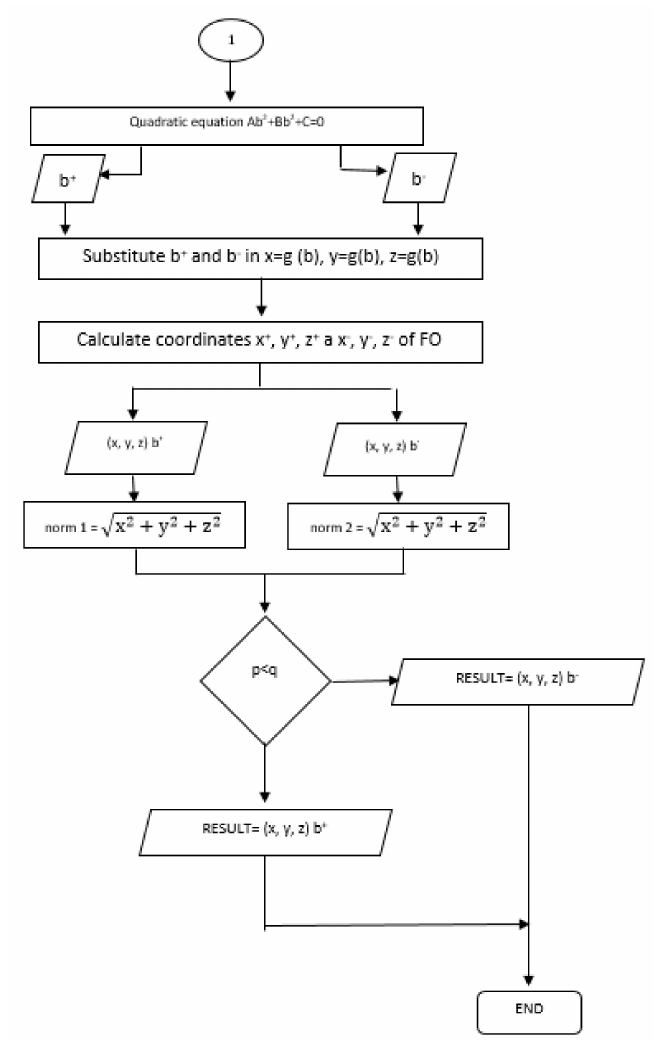
Figure 1. The flowchart of the proposed algorithm.